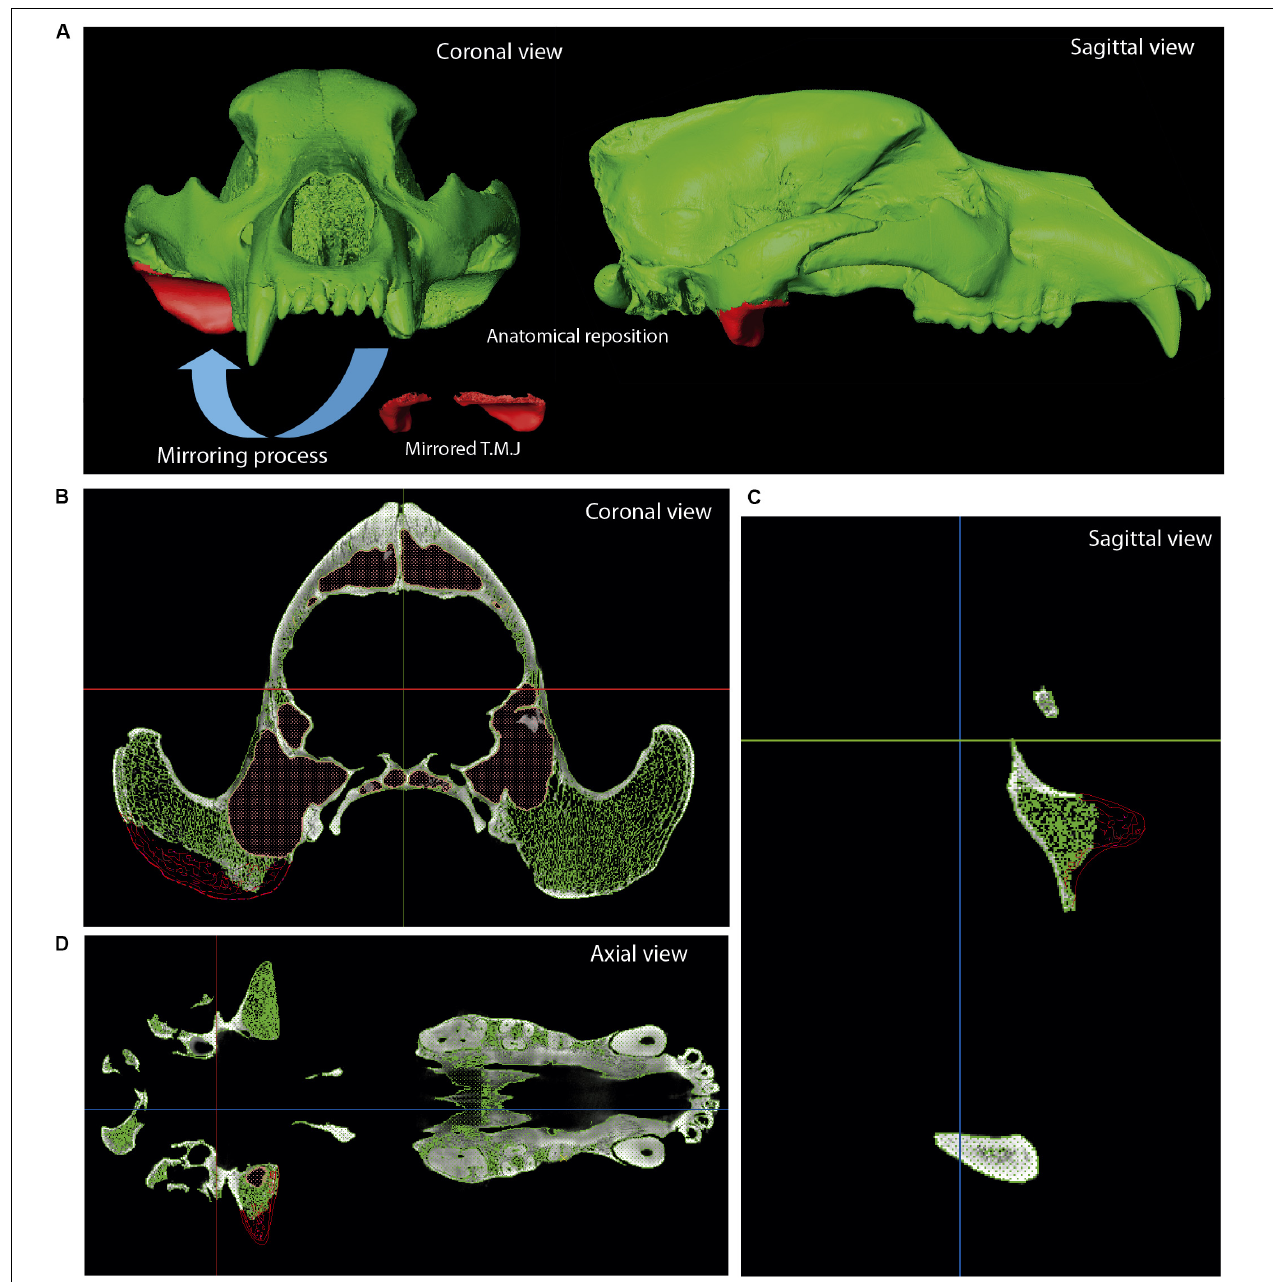
FIGURE 8 | Reconstruction of Ursus spelaeus ladinicus (PIUW-CU 703). (A) Coronal, sagittal, and perspective views of the 3D virtual models showing the red the polyline used to mirror the left TMJ. Actual bone in green. The lacking right TMJ is shown in sagittal (B) , coronal (C) , and axial views (D) . Abbreviation: TMJ, temporomandibular